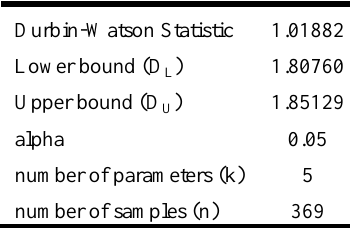
Table 8. Durbin-Watson Test results